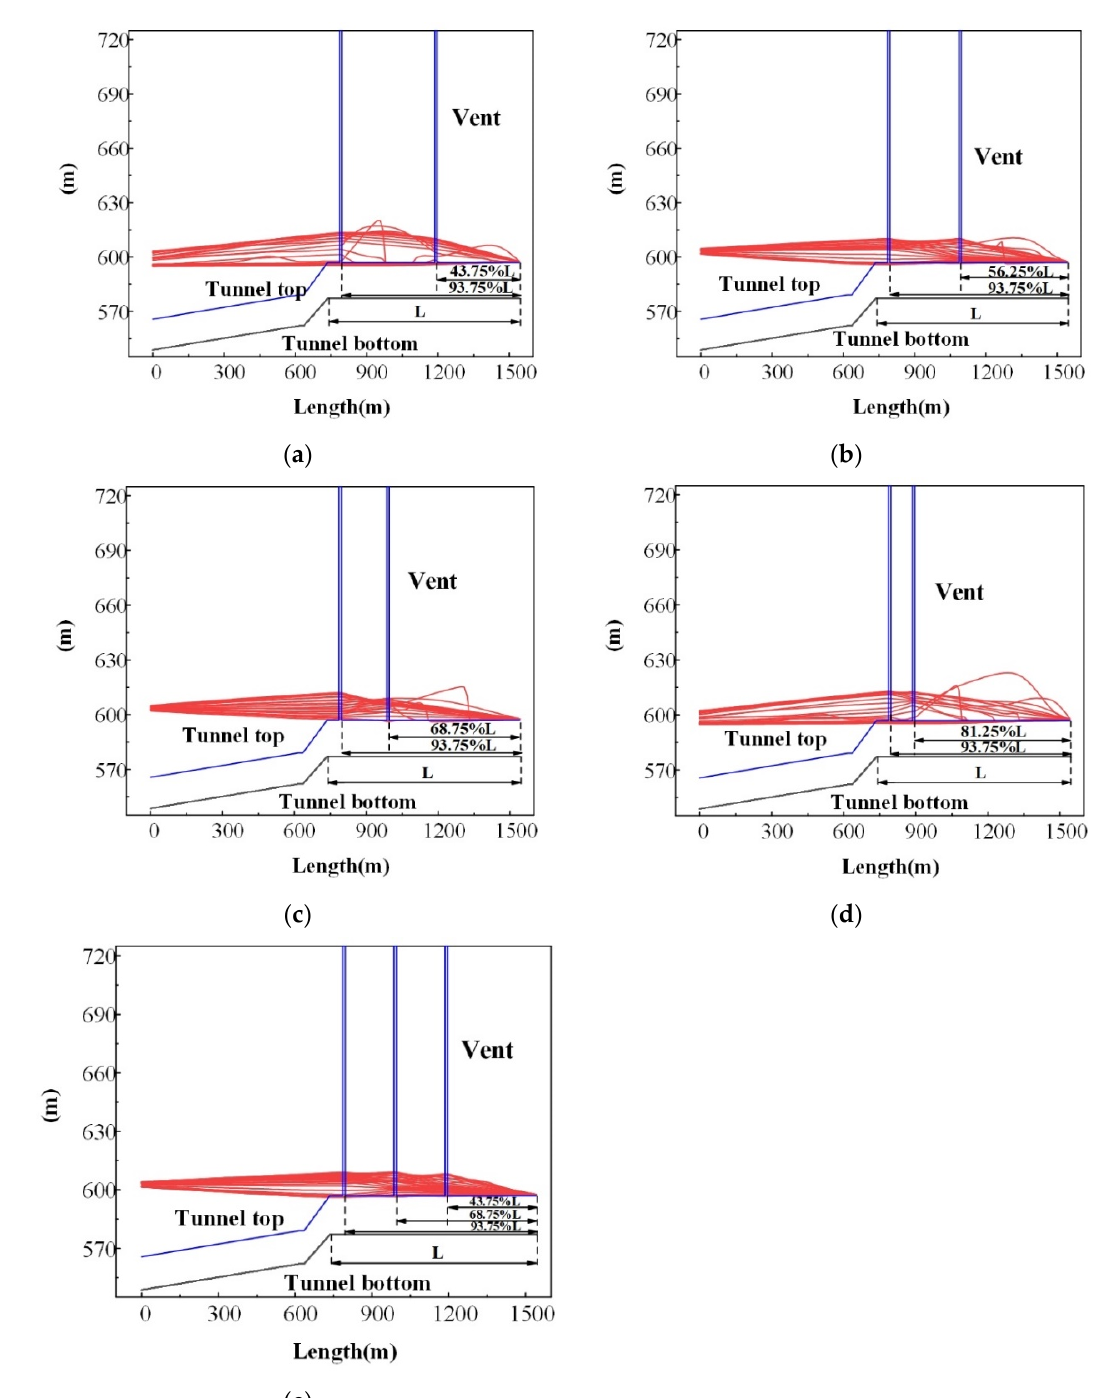
Figure 6. Water level with different numbers of vents: ( a ) 93.75%L/43.75%L, ( b ) 93.75%L/56.25%L, ( c ) 93.75%L/68.75%L, ( d ) 93.75%L/81.25%L, and ( e ) 93.75%L/68.75%L/43.75%L.